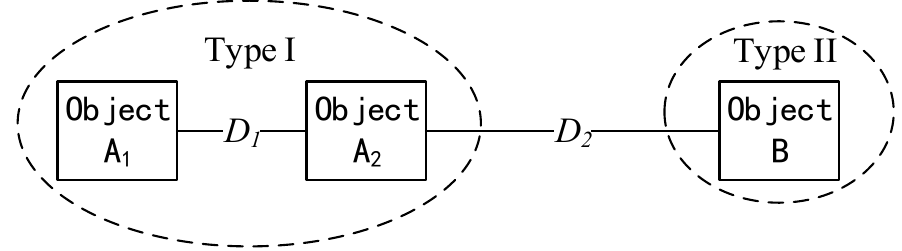
Figure 5. A schematic diagram showing the rule of the similarity measure.